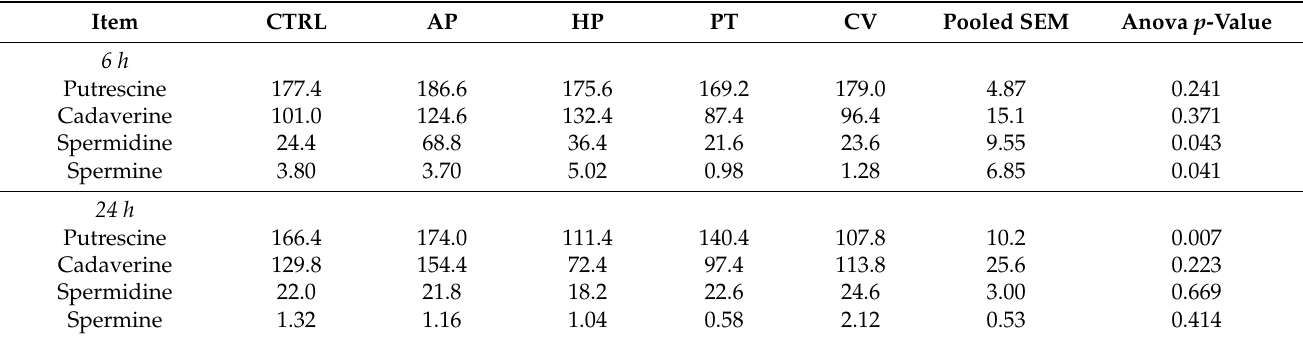
Table 6. Biogenic amines concentrations (nmol/mL) 6 h and 24 h of an in vitro incubation of canine fecal inoculum with a control diet supplemented with microalgae 1 .